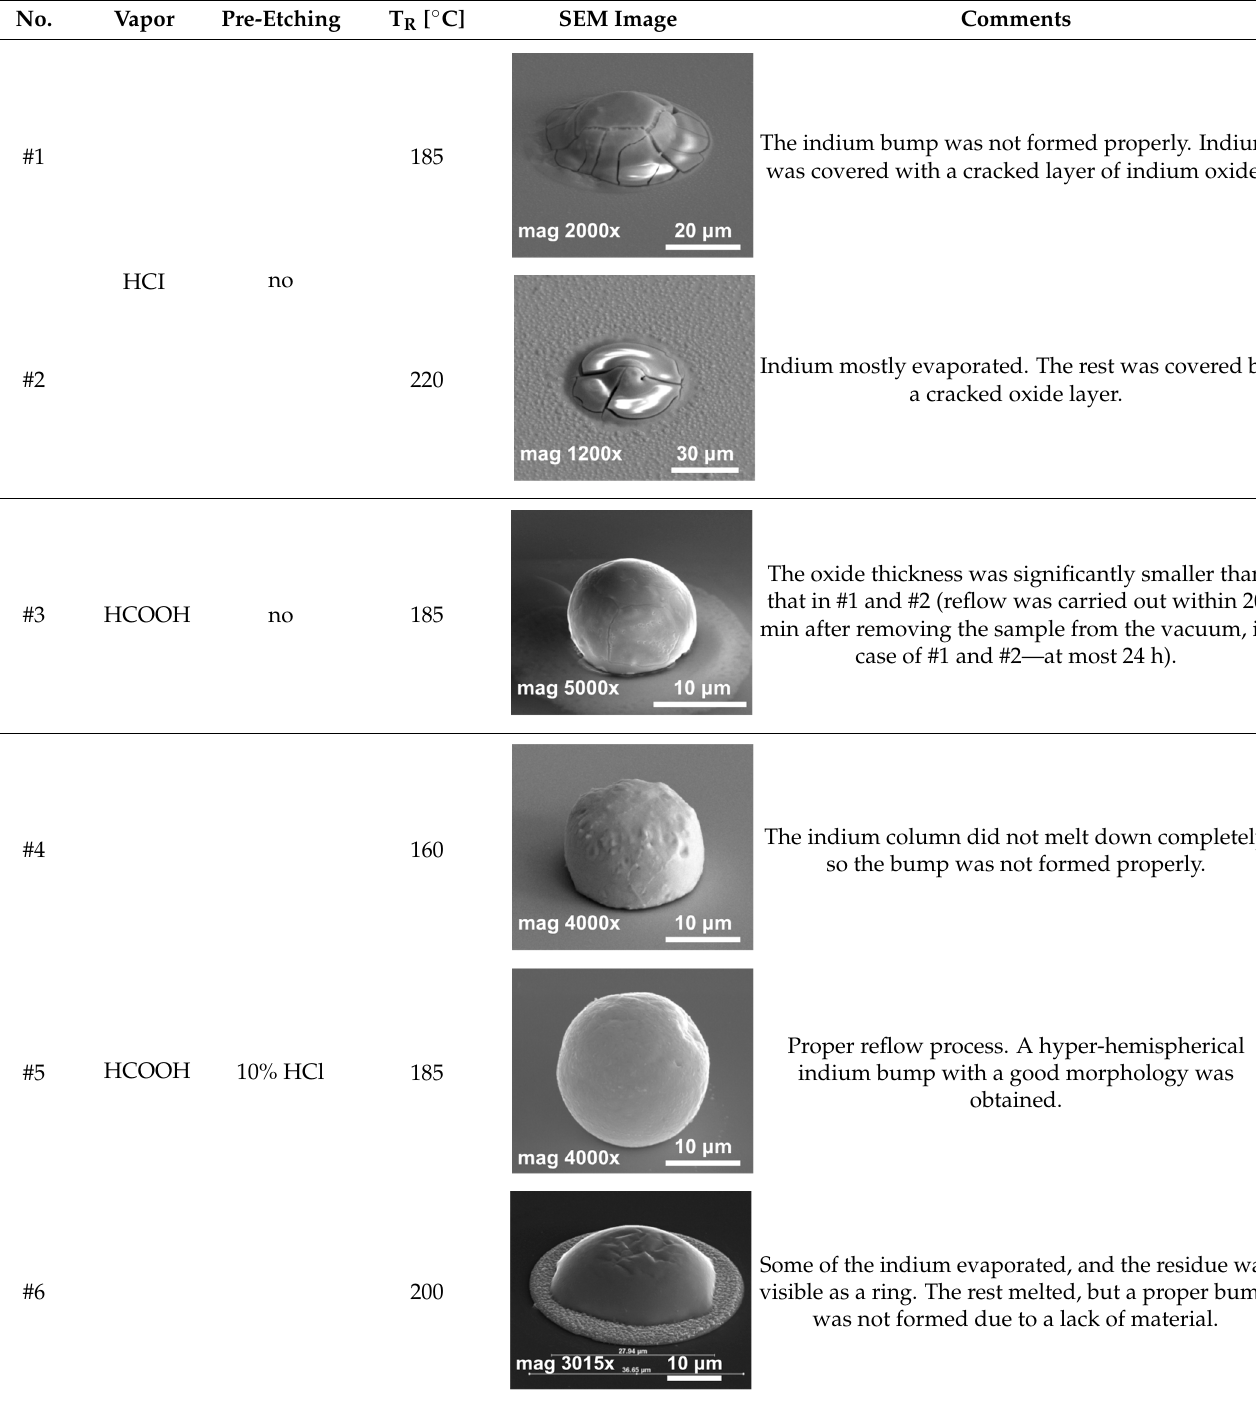
Table 1. Results of the performed reflow processes.